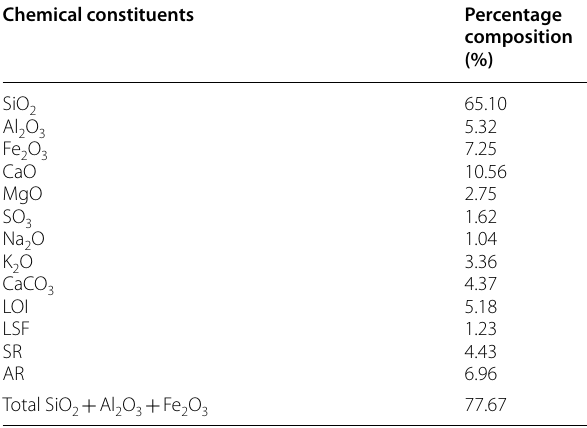
Table 2 Chemical composition of